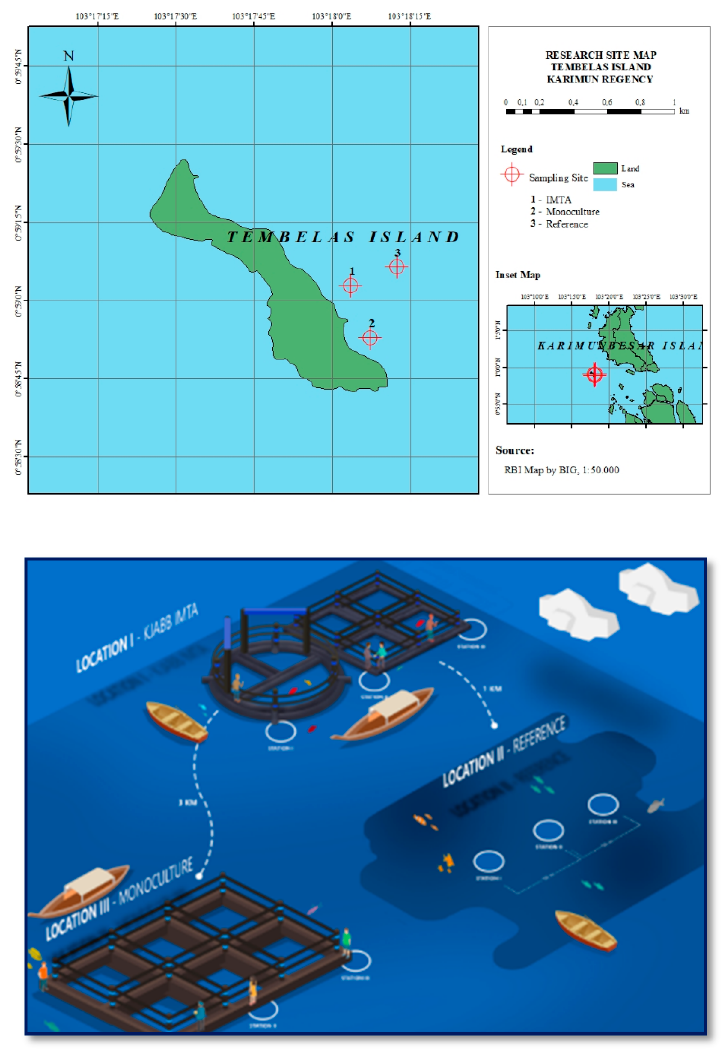
Figure 1. The three sampling locations at the coastal area of Tembelas Island, Strait Malaka, Kepulauan Riau Province, Indonesia.